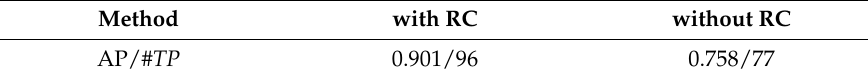
Figure 6. Precision versus recall curve for the HRRS dataset with/without RC. Table 3. The AP and # TP on the HRRS dataset with or without RC.